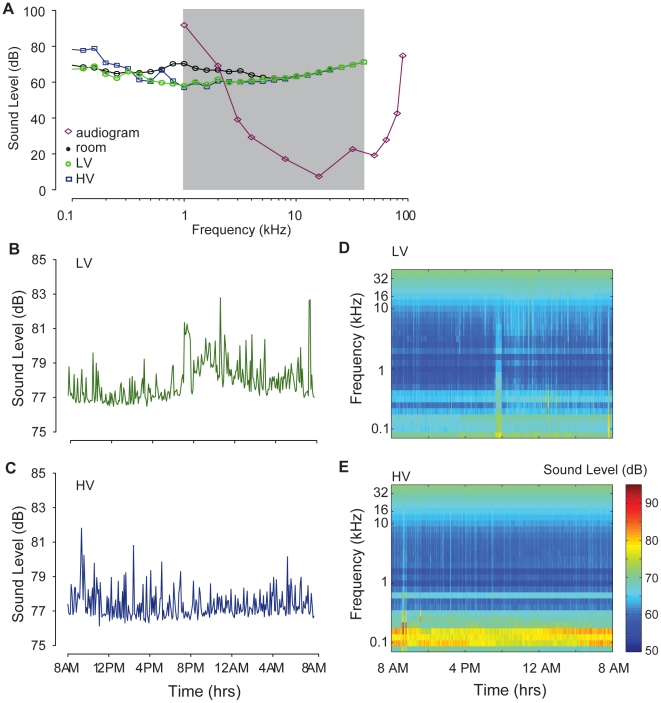
Sound levels are not affected by cage environment.
A. Sound levels (dB) computed in 1/3-octave bands (80 Hz–40.3 kHz) for the two cage conditions: LV (green), and HV (blue). An additional acoustical measurement was taken outside the cage (room, black). The audiogram (purple) of the mouse is replotted from [25]. The shade region indicates the range of sound frequencies over which the broadband sound levels were computed in B-C. Broadband sound levels computed every 5 minutes over the range of frequencies indicated by the shading in A (1–40.3 kHz). D-E. Spectrograms showing sound level in 1/3-octave bands (color bar, right-hand side of panel E) measured every 5 minutes over a 24 hr period.